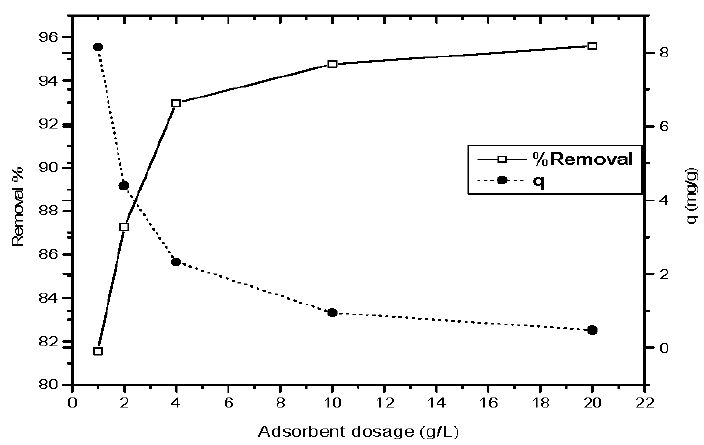
Figure 6. Influence of magnetic ZnO nanotubes dosage on both phenol percentage removal and phenol uptake capacity (pH = 5, initial phenol concentration = 10 ppm, agitation speed = 440 rpm, contact time = 90 min and temperature = 25 °C).